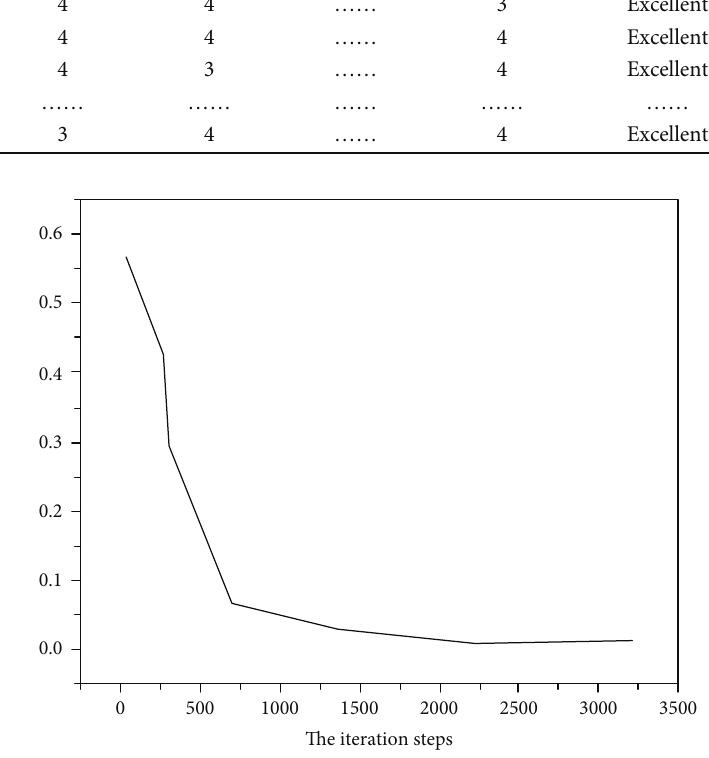
Figure 4: Decrease curve of RBF approximation error during the training.